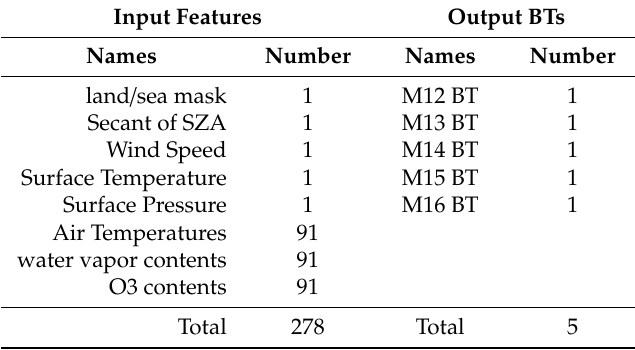
Table 1. Summary of input features and output brightness temperatures (BTs) in the fully connected “deep” neural network algorithm with the Community Radiative Transfer Model (FCDN_CRTM). SZA: satellite zenith angle.